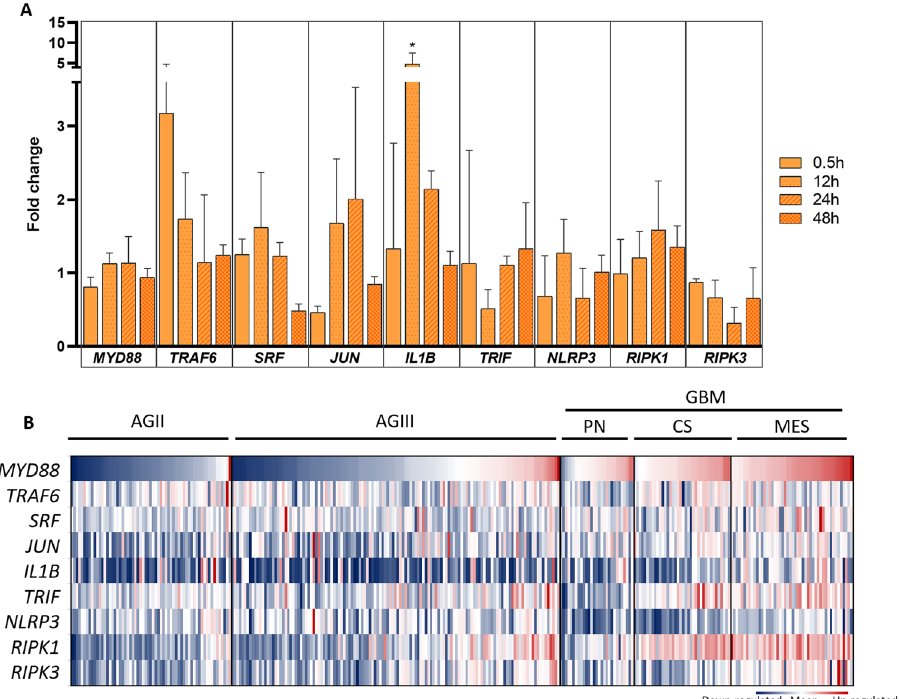
Figure 3. Canonical and non-canonical gene expression profile after LPS stimulation of U87MG cells and of TCGA astrocytoma RNASeq data. ( A ) MYD88, TRAF6, JUN, SRF, IL1B, TRIF, NLRP3, RIPK1,